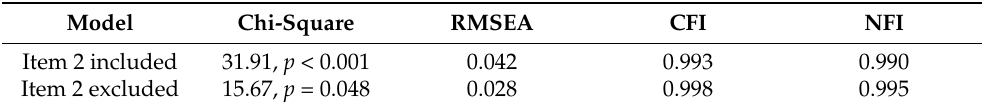
Table 2. Results of the confirmatory factor analyses for model suggested by Ristic et al. (2016), with and without questionnaire Item 2 (“I will drink almost any wine”). Model Chi-Square RMSEA CFI